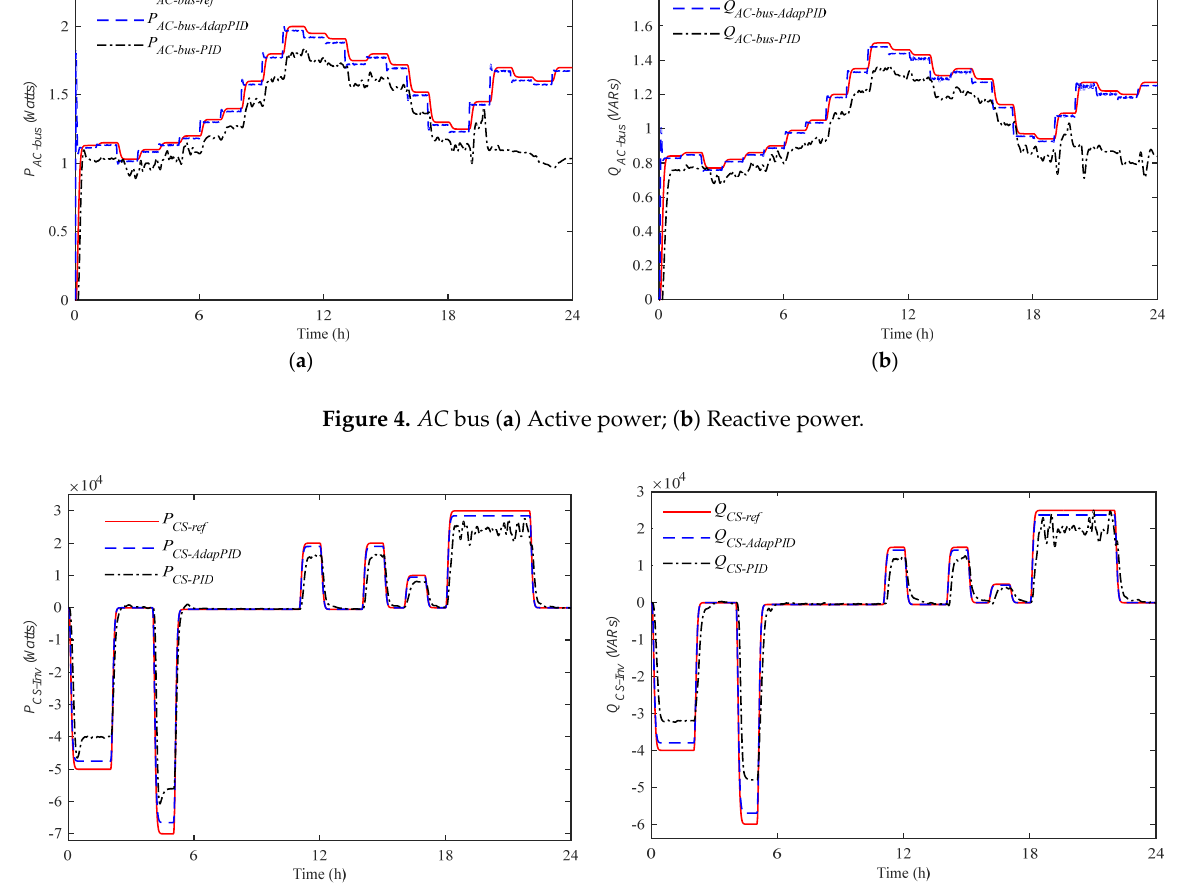
Figure 5. CS converter ( a ) Active power ( b ) Reactive power.